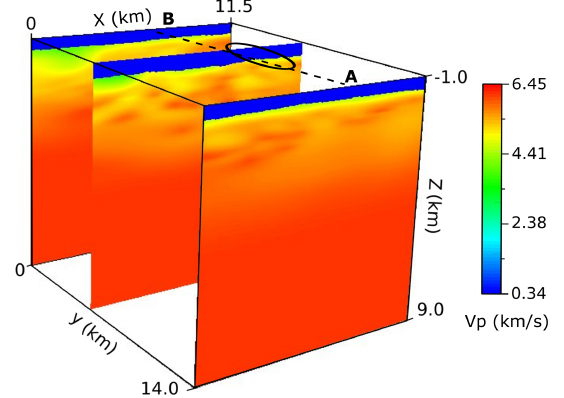
Figure 5. The P-wave velocity model used in this study (after Hloušek et al., 2015). The dashed black line AB corresponds to the vertical slice in Fig. 7, and the solid black ellipse shows the approx- imate surface area where the receivers are